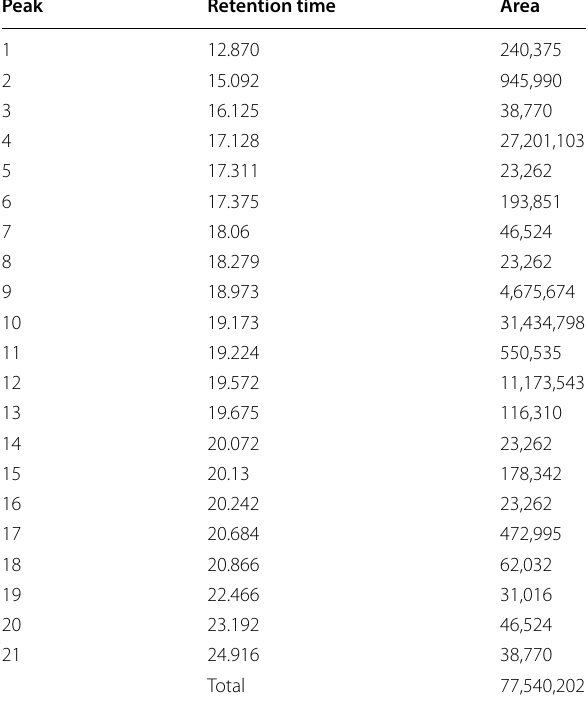
Table 2 PORIM specification of biodiesel composition (Crabbe et al. 2001)